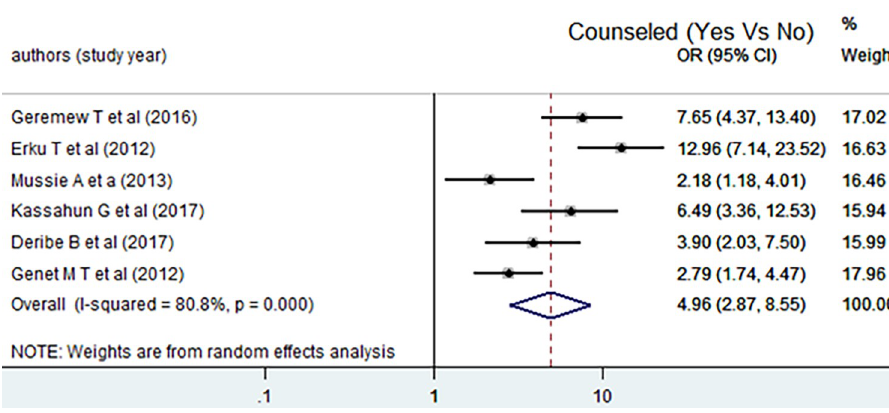
Fig 5. Forest plot of the pooled estimate of the effect of counseling on disclosing HIV positive status to sexual partner, a systematic review and meta-analysis, Ethiopia, 2020.